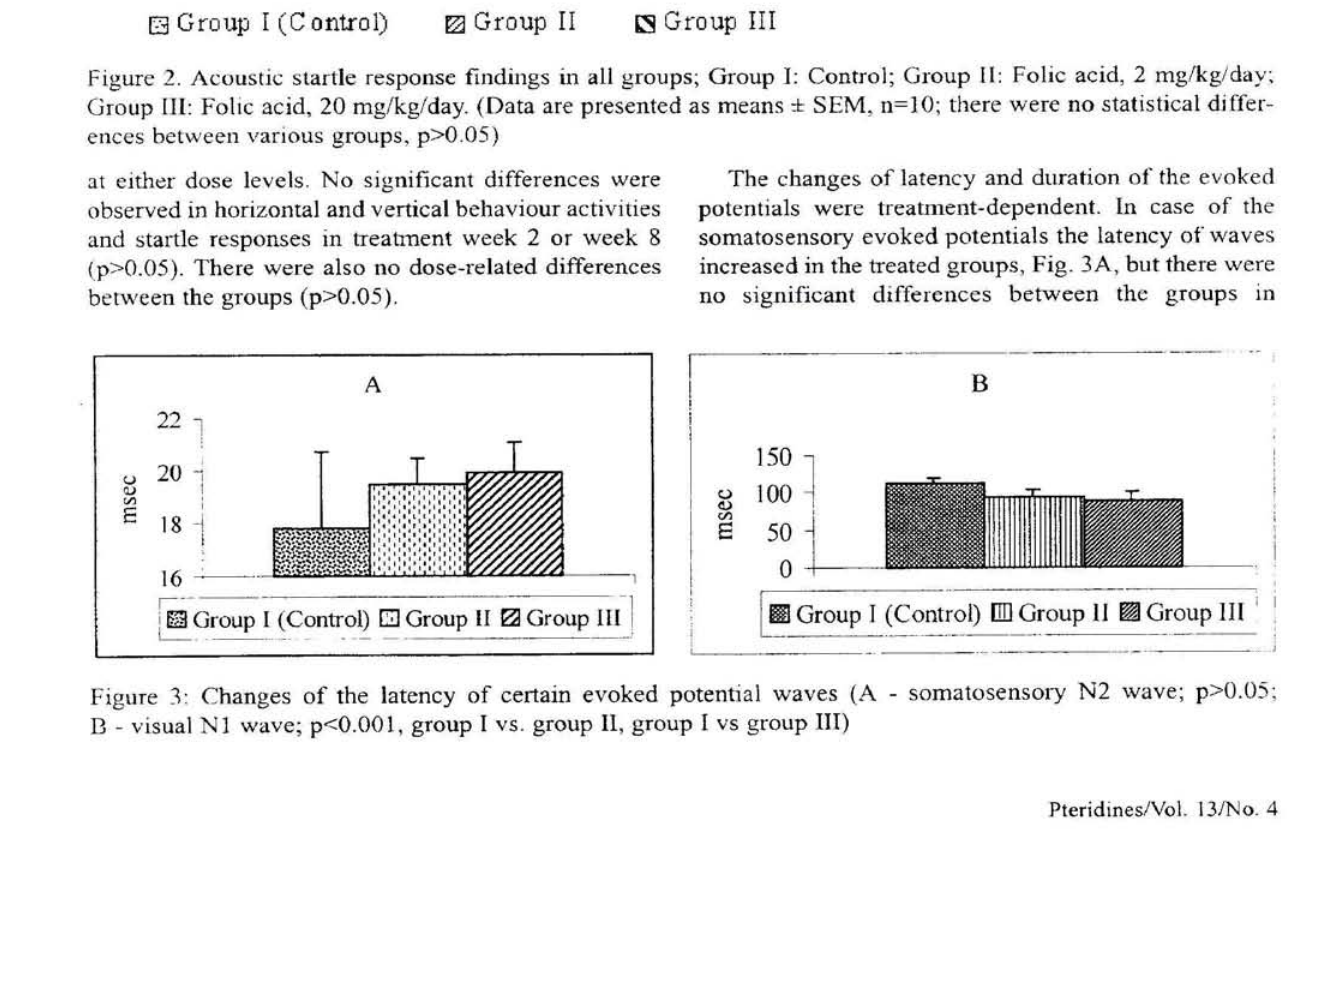
Pteridines/Vol. 13/No.